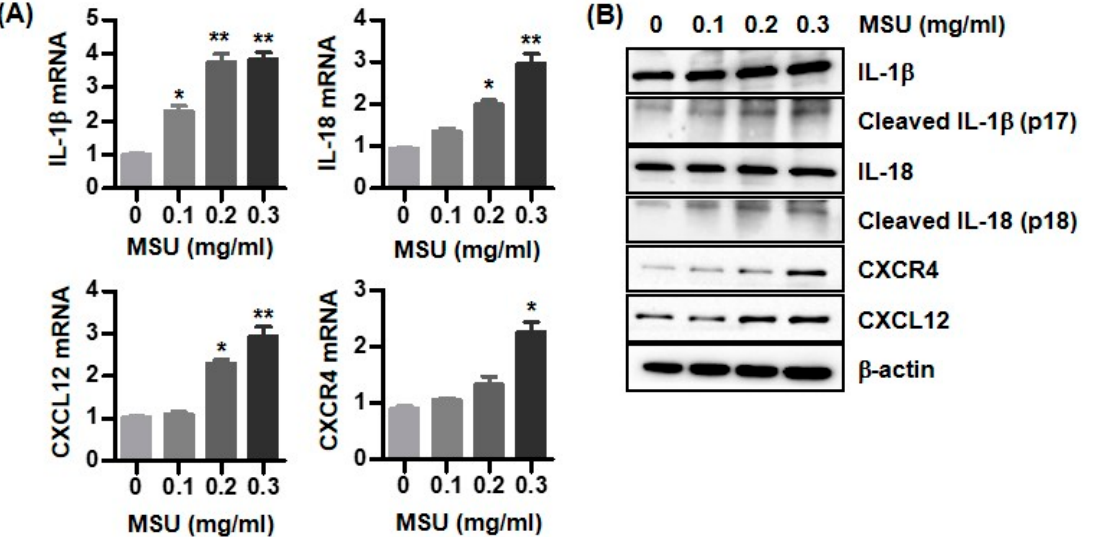
Figure 2. Effect of MSU crystals on expression of IL-1 β , IL-18, CXCR4, and CXCL12 in U937 cells. ( A ) IL-1 β , IL-18, CXCR4, and CXCL12 mRNA expression in U937 cells incubated with MSU crystals (0.1, 0.2, and 0.3 mg/mL). ( B ) IL-1 β , IL-18, CXCR4, and CXCL12 protein expression in cells treated with MSU crystals. * p < 0.05 and ** p < 0.01 compared with cells without MSU crystal stimulation . The images are representative of three independent experiments.